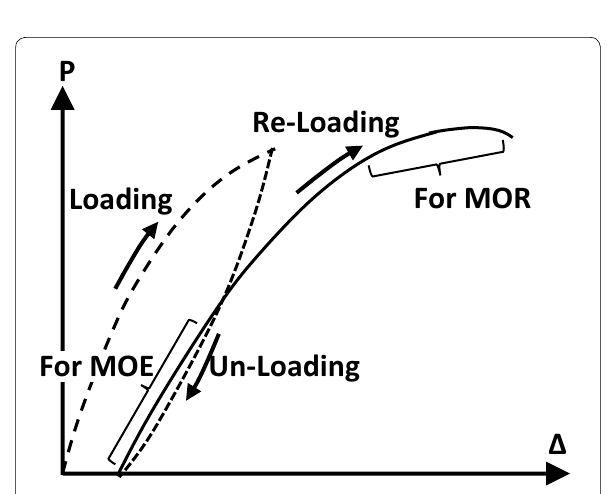
Fig. 4 The loading cycle of a